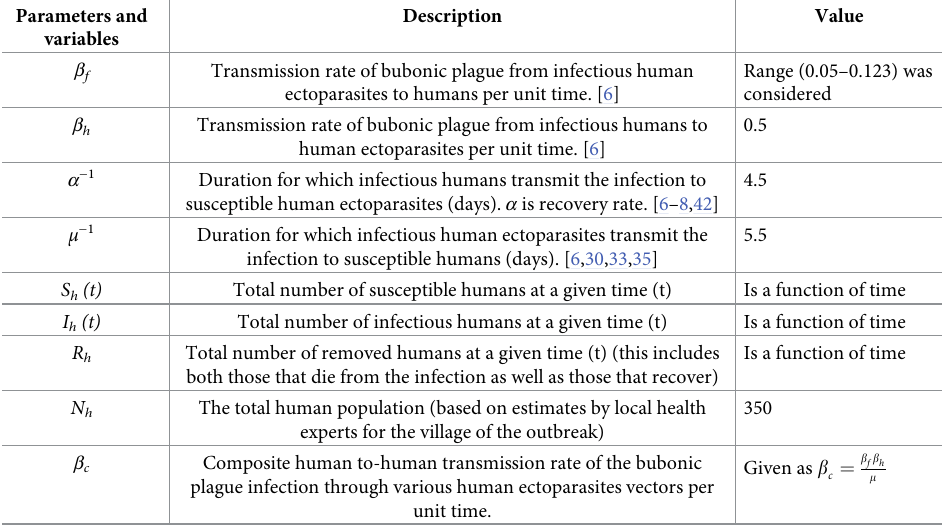
Note: Single values given as approximate point